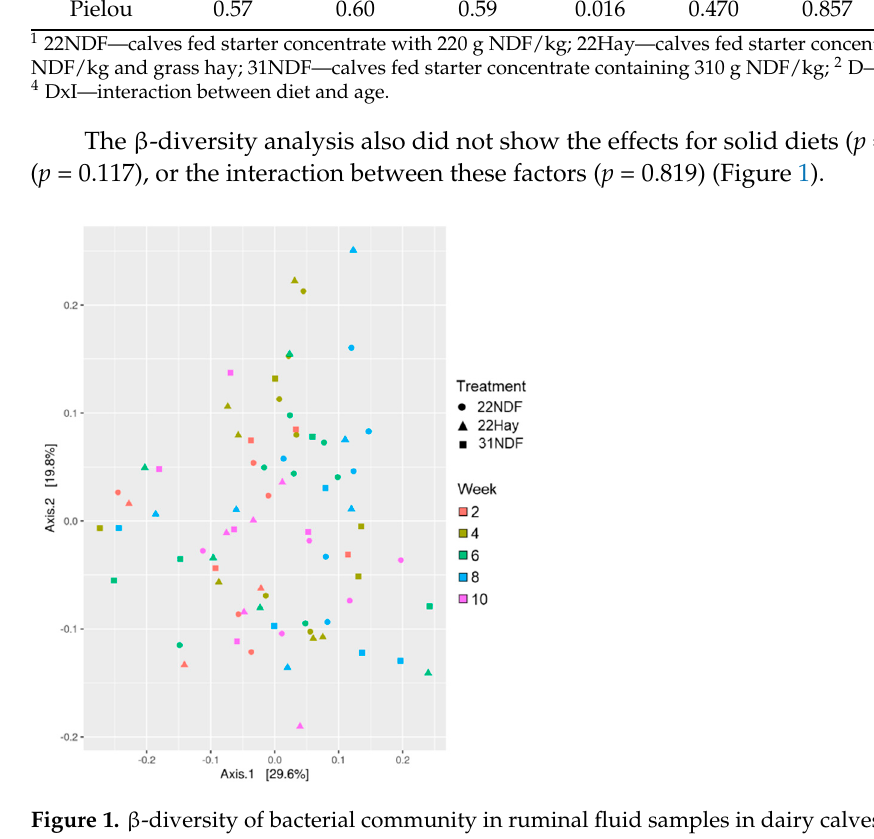
Figure 2. Relative abundance of bacterial phyla and genera in ruminal fluid samples during pre- and post-weaning in dairy calves fed different levels and sources of NDF. Of these 16 phyla, 259 genera were quantified. Among these genera, the most prevalent were Prevotella (21.87%), the Lachnospiraceae NK3A20 group (8.47%), Succiniclasticum (4.08%), Olsenella (3.69%), and Ruminococcus (2.72%), corresponding to 40.83% of the total (Supplementary Table S5). The variation in the abundance of these genera can be seen in Figure 2b. All taxonomic abundance differential data were reported in the Supplementary Table S6. Figure 3 shows eight bacterial genera at a relative abundance of ≥ 1%, as a heat-map. A few bacterial genera had an abundance above 1%. Acidaminococcus , Akkermansia ,